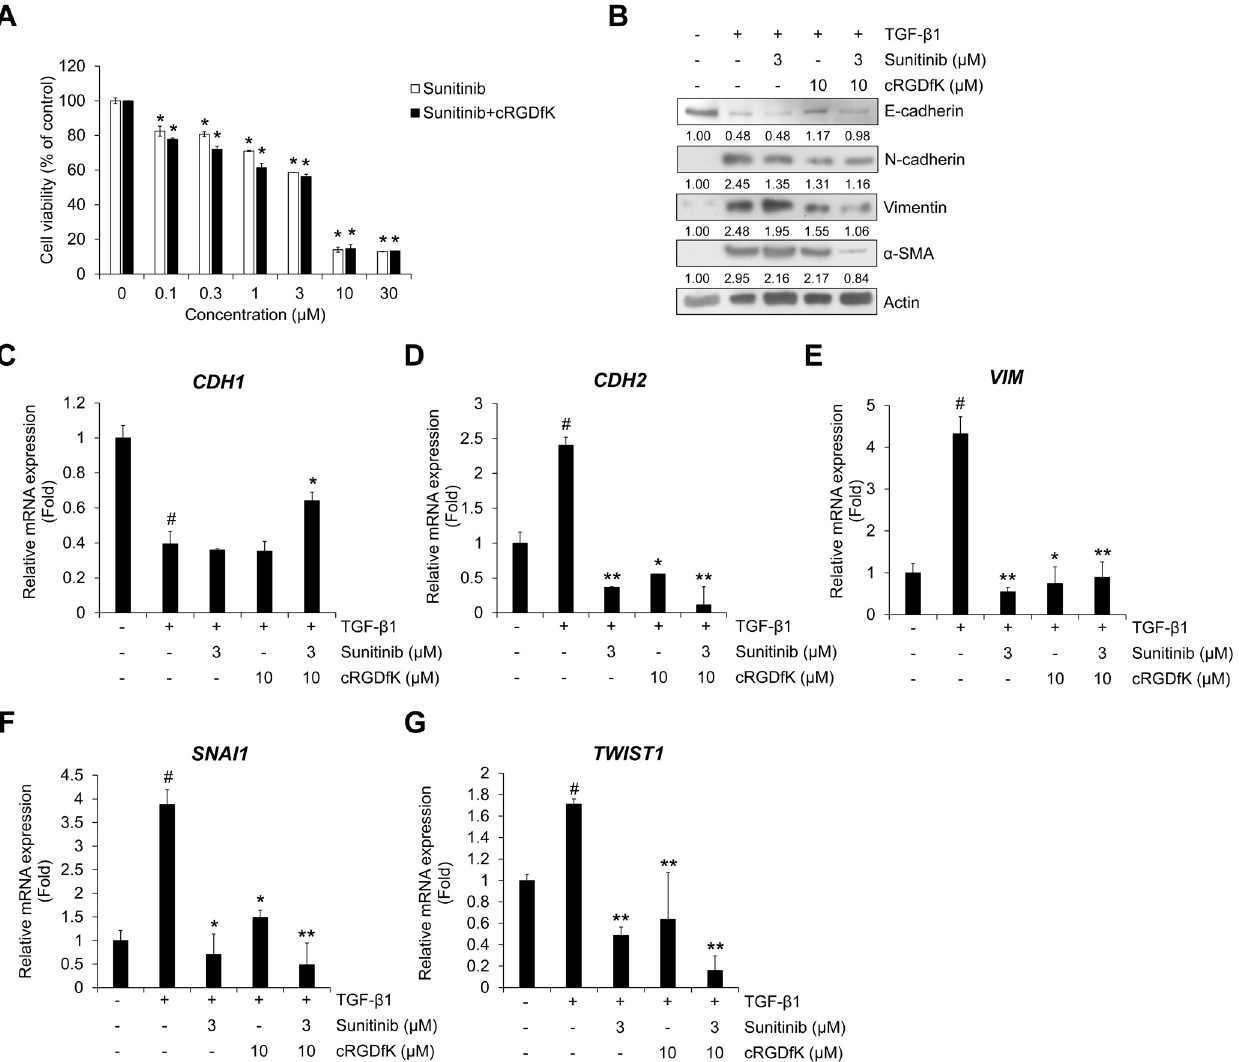
Fig 7. Combination of sunitinib with cRGDfK shows enhanced inhibitory effects on cell viability and TGF- β 1-induced EMT expression. (A) A549 cells were treated with sunitinib or a combination of sunitinib plus cRGDfK for 24 h before measuring cell viability. Data represent mean ± SD. � p < 0.01 vs. sunitinib-free controls. (B) Serum-deprived A549 cells were pretreated for 3 h with sunitinib (3 μ M) and cRGDfK (10 μ M) individually or in combination, and then incubated with TGF- β 1 (5 ng/mL) for 72 h. The expression of EMT markers was measured by Western blot. Actin was used as a loading control. (C–G) A549 cells were pretreated with sunitinib or a combination of sunitinib plus cRGDfK for 3 h and incubated with TGF- β 1 (5 ng/mL) for 48 h (C–E) or 1 h (F and G). The mRNA expression of the indicated genes was measured by qRT-PCR using GAPDH as an internal control. Experiments were performed in triplicate. Data represent the mean ± SD of raw results. # p < 0.01 versus control, � p < 0.05, �� p < 0.01 versus treatment with TGF- β 1 only. https://doi.org/10.1371/journal.pone.0232917.g007 PLOS ONE | https://doi.org/10.1371/journal.pone.0232917 August 18,